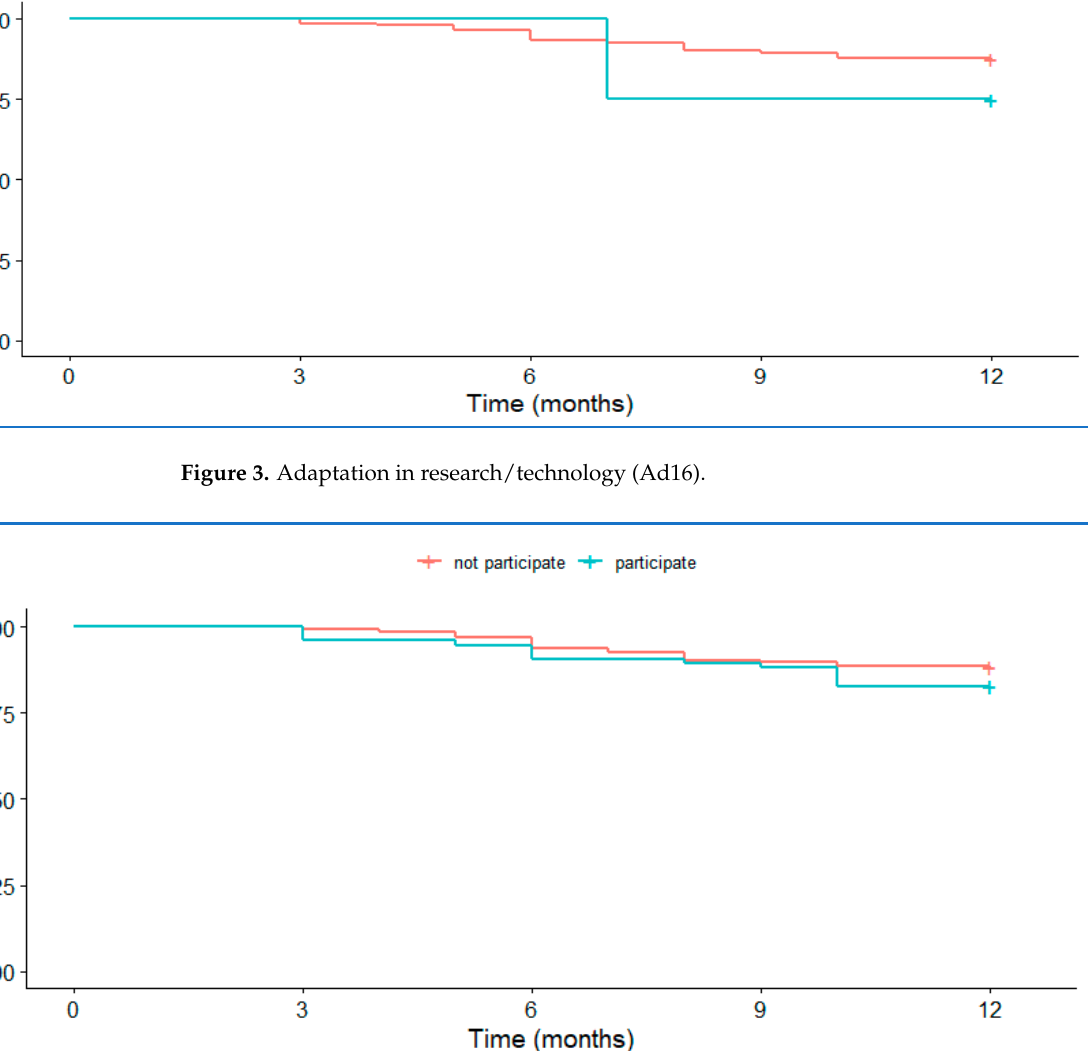
Figure 4. Debt moratorium/waiver of debt repayment/debt correction NPL program participation